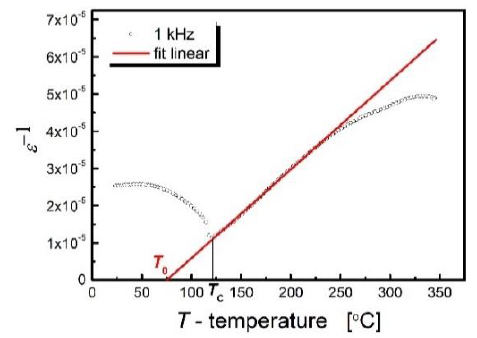
Figure 4. Inverse relative electrical permittivity from temperature for BLT4 ceramics.